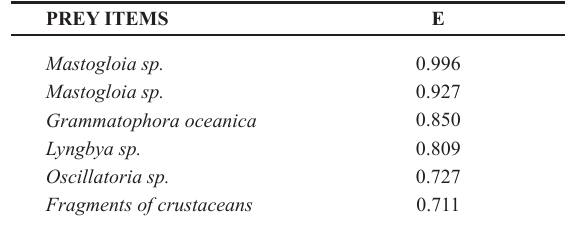
TABLE II Ivlev´s electivity index (E) of the six most important food items found in gastric cavities of the polyps of Carijoa riisei during the sampling period in Porto de Galinhas beach (values >0 represent positive, and values <0 negative selection) PREY